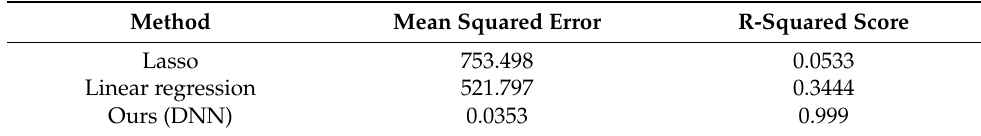
Table 4. Comparison with other machine learning techniques.